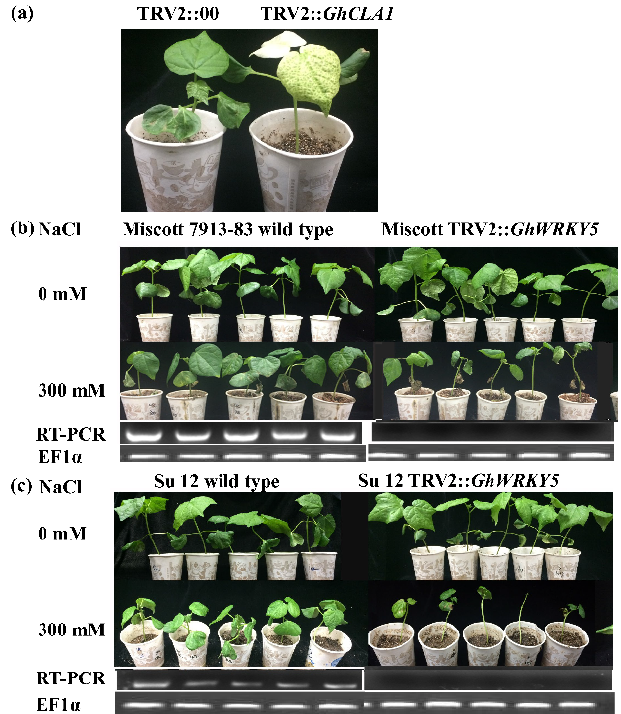
Figure 2. The identification of salt tolerance in the GhWRKY5 -silenced plants by virus-induced gene silencing (VIGS). ( a ) The leaves of TM-1 turned white after TRV2:: GhCLA1 gene silencing, and empty vector (TRV2:00) leaves remained as green as the wild-type (WT) TM-1. ( b ) The leaves of “Miscott”, a salt-tolerant cultivar, withered, and new leaves grew slowly. ( c ) The leaves of “Su12”, a salt-sensitive cultivar, withered, fell off, and new leaves grew slowly. VIGS experiments were repeated at least three times with more than 10 plants for each construct per repeat.